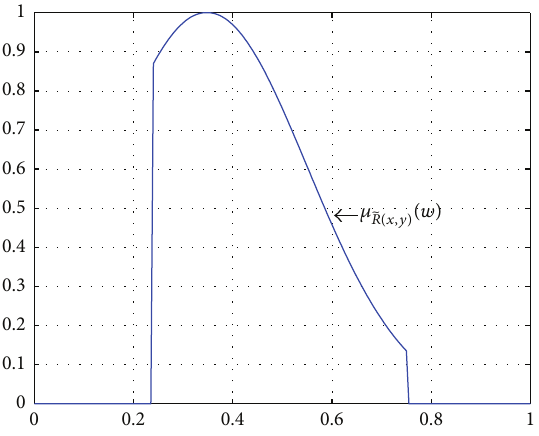
Figure 3: The function graph of 𝜇 ̃𝑅(𝑥,𝑦) (𝑤) in (79).